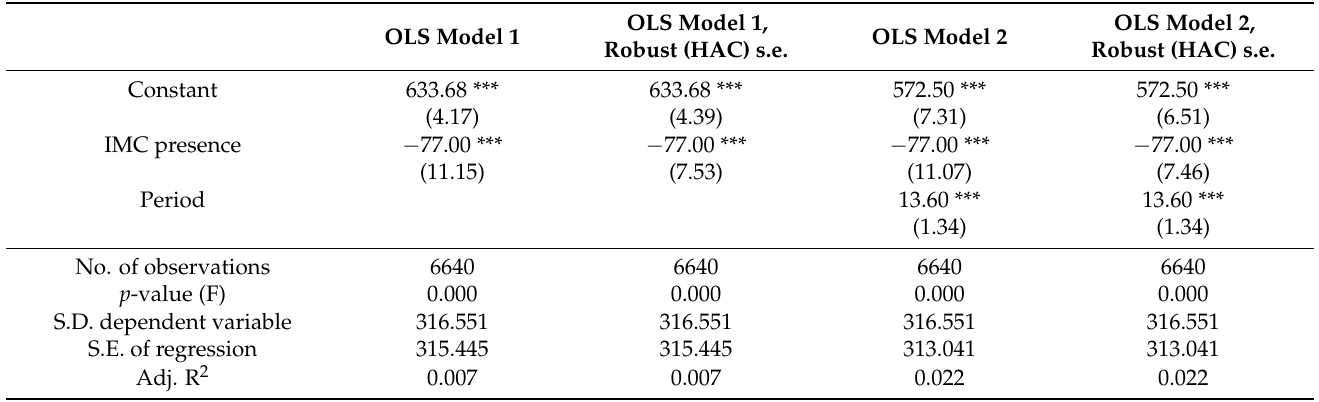
Table 3. Regression analysis of IMC presence on MSWM expenditures/capita (CZK), 2010–2019 pooled data, 664